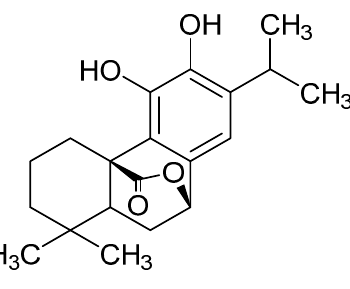
Figure 1. Chemical structure of carnosol.